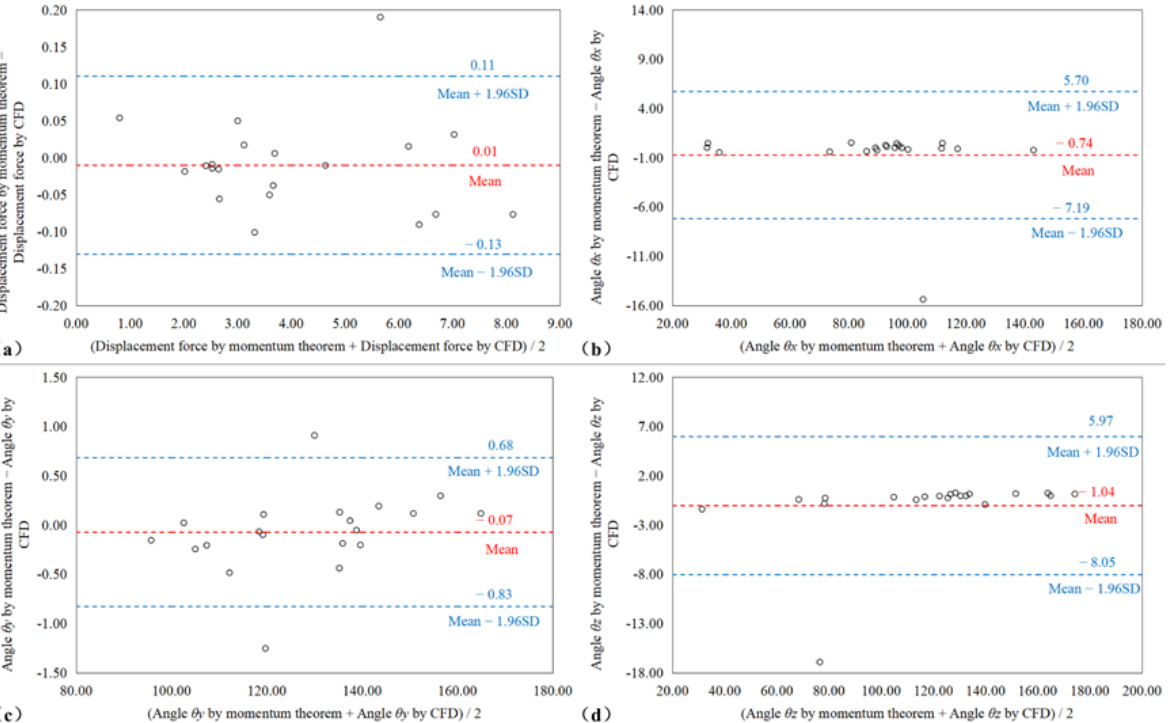
and θ z . The SG7 and SG8 patients slightly exceeded the limit on θ y .